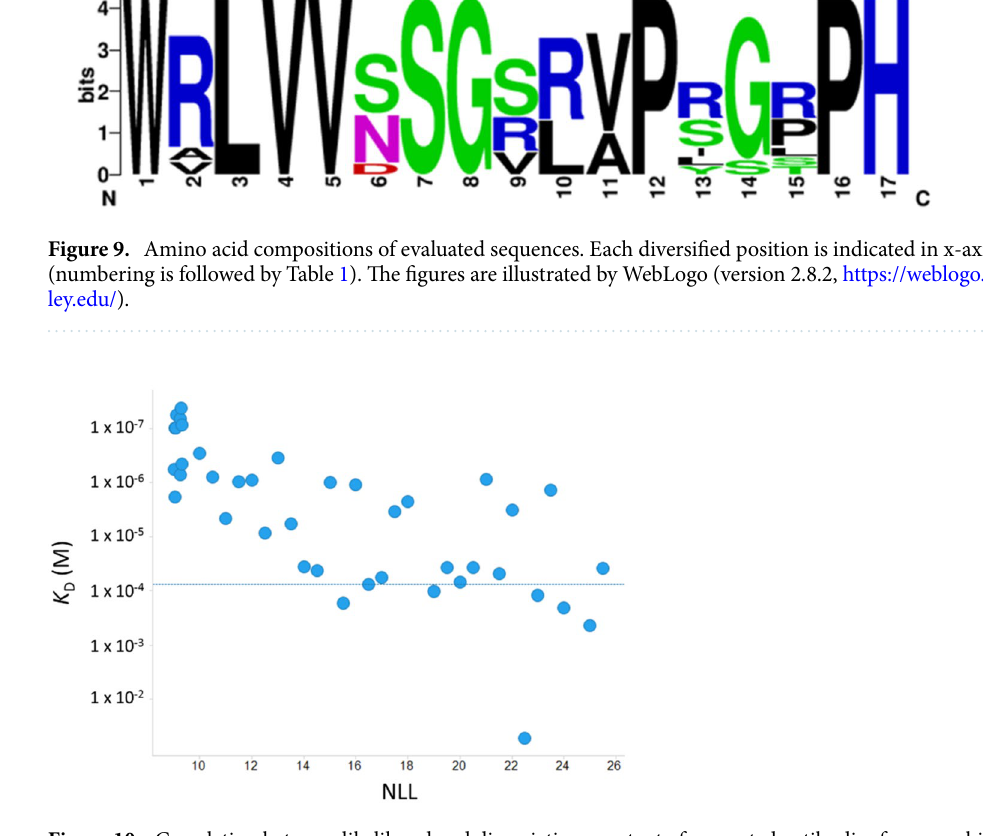
The dissociation constants against kynurenine and NLL of sequences generated through machine learning are plotted (Fig. 10). The data revealed a positive correlation between binding activity and likelihood (R 2 :0.52). The ratio of sequences with higher binding activity than the parent are 100% (20/20) (NLL < 15), 70% (7/10) (15 ≦ NLL < 20) and 58% (7/12) (20 ≦ NLL). A box plot of the top ten sequences identified by machine learning (NLL) and NGS reads is illustrated in Fig. 11. Median values of dissociation constants are 9.7 × 10 –8 M (machine learning) and 3.5 × 10 –6 M (NGS reads). The highest dissociation constants for each sequence are 4.2 × 10 –8 M (machine learning) and 2.8 × 10 –7 M (NGS reads). The highest affinity acquired through machine learning is more than 1800-fold higher than that of the parental clone (Supplementary Fig. 2). This result indicates that machine learning approach generates compelling results that experimental work would take longer and not as efficiently to achieve.